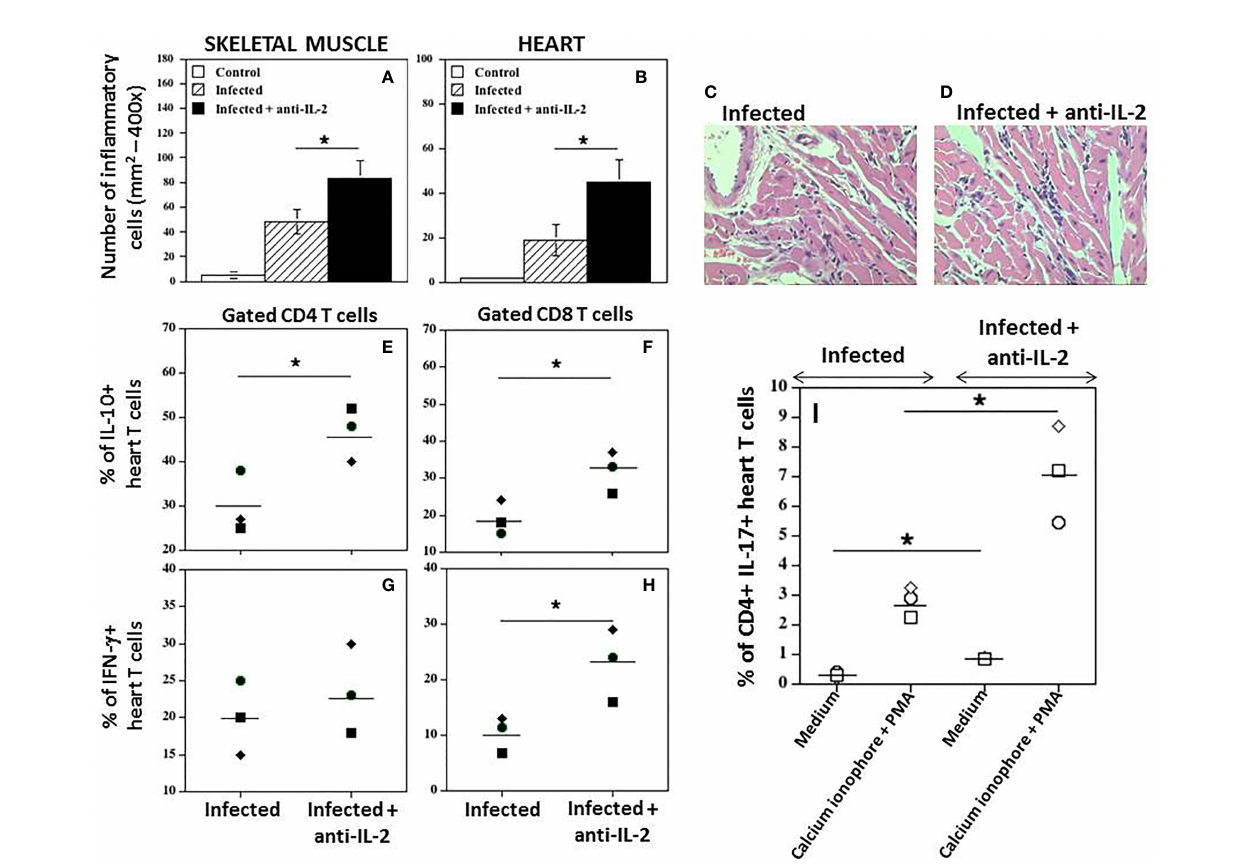
FIGURE 7 | In vivo administration of anti-IL-2 mAb augments heart tissue in fl ammation and the numbers of heart T cells producing IFN- g , IL-10, and IL-17. Figure 7 shows the number of in fl ammatory cells in mice treated with anti-IL-2 in the skeletal muscle (A) and heart (B) , compared to uninfected or infected control mice treated with rat Ig (*P < 0.05, n = 5-7 group, Mann-Whitney test). Representative heart sections from Ig-treated and anti-IL-2 treated C57Bl/6 infected mice are shown in panels (C, D) , respectively, using a 40x objective. Panels (E – H) show the percentage of heart CD4+ and CD8+ T cells producing IL-10 and IFN- g , respectively, compared to the infected control group treated with rat Ig. Tissue-derived cells were stimulated with anti-CD3 mAb for 24 hours, followed by brefeldin-A for the last 6 hours. Panel (I) shows the percentage of heart CD4+ T cells producing IL-17 in infected mice treated with anti-IL-2 mAb compared to infected controls injected with rat Ig. In this experimental set, cells were incubated with complete medium alone or activated with Cell Stimulation Cocktail for 36 hours, followed by brefeldin-A for the last 6 hours. (PMA plus ionomycin, Tonbo Biosciences, San Diego, CA, USA). All tissues were removed after 21 days of infection. Each symbol represents one independent experiment done with pooled cells from 3 to 5 mice per group. (*P < 0.05, Mann-Whitney